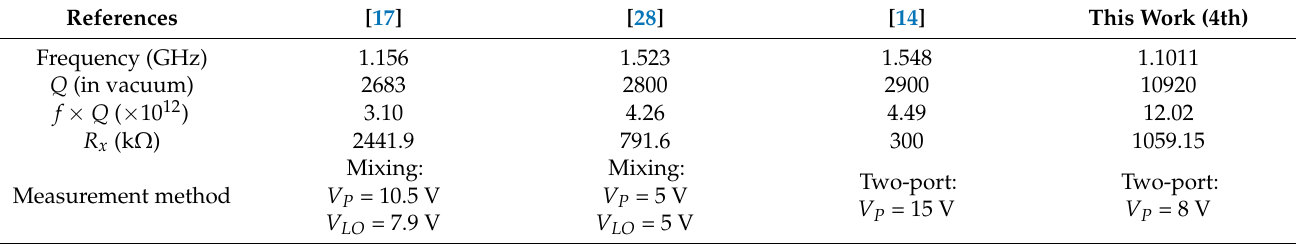
Table 5. The comparison between the reported GHz resonators and this